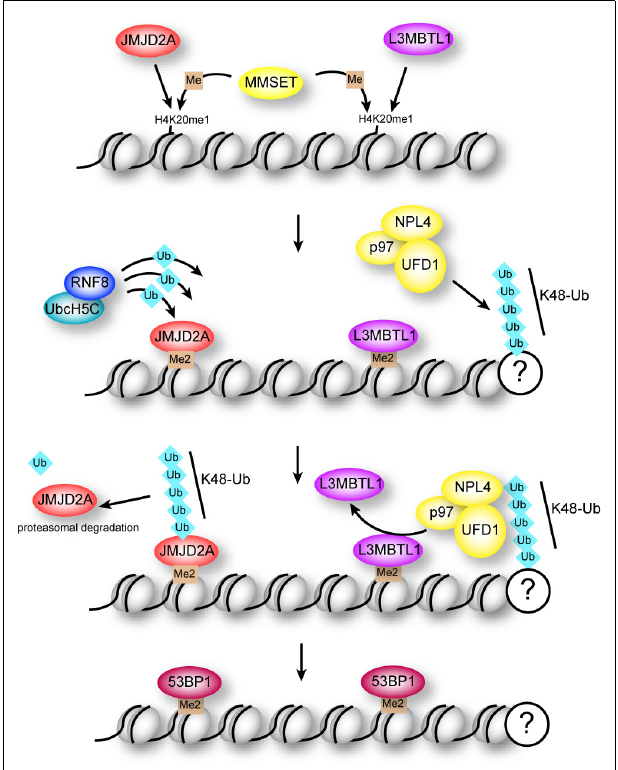
FIGURE 2 | Regulation of 53BP1 association with H4K20me2 at sites of DNA damage. The methyltransferase MMSET promotes di-methylation of mono-methylated lysine 20 in histone H4 (H4K20me1) at DNA breaks. Binding of 53BP1 to H4K20me2 is opposed by methyllysine-binding proteins JMJD2A and L3MBTL1 in two potentially overlapping pathways. Proteasomal degradation of JMJD2A is triggered by RNF8-dependent ubiquitination, while ejection of L3MBTL1 is mediated by the ubiquitin-dependent segregase p97.